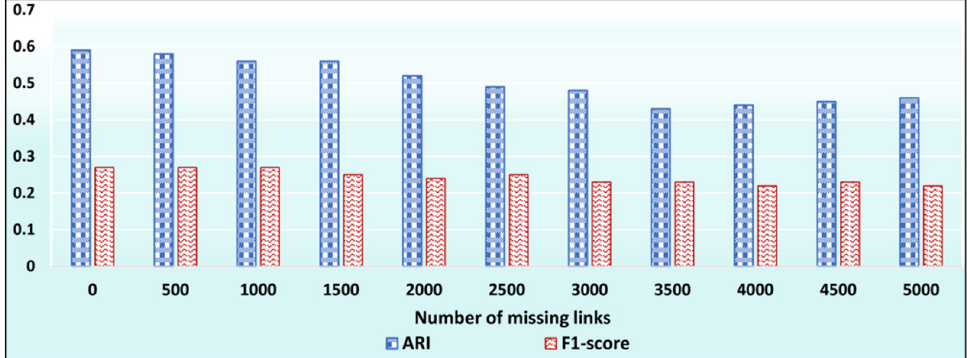
Fig 32. The accuracy of ID_CC in detecting the DBLP communities after identifying and reinstating the missing Association